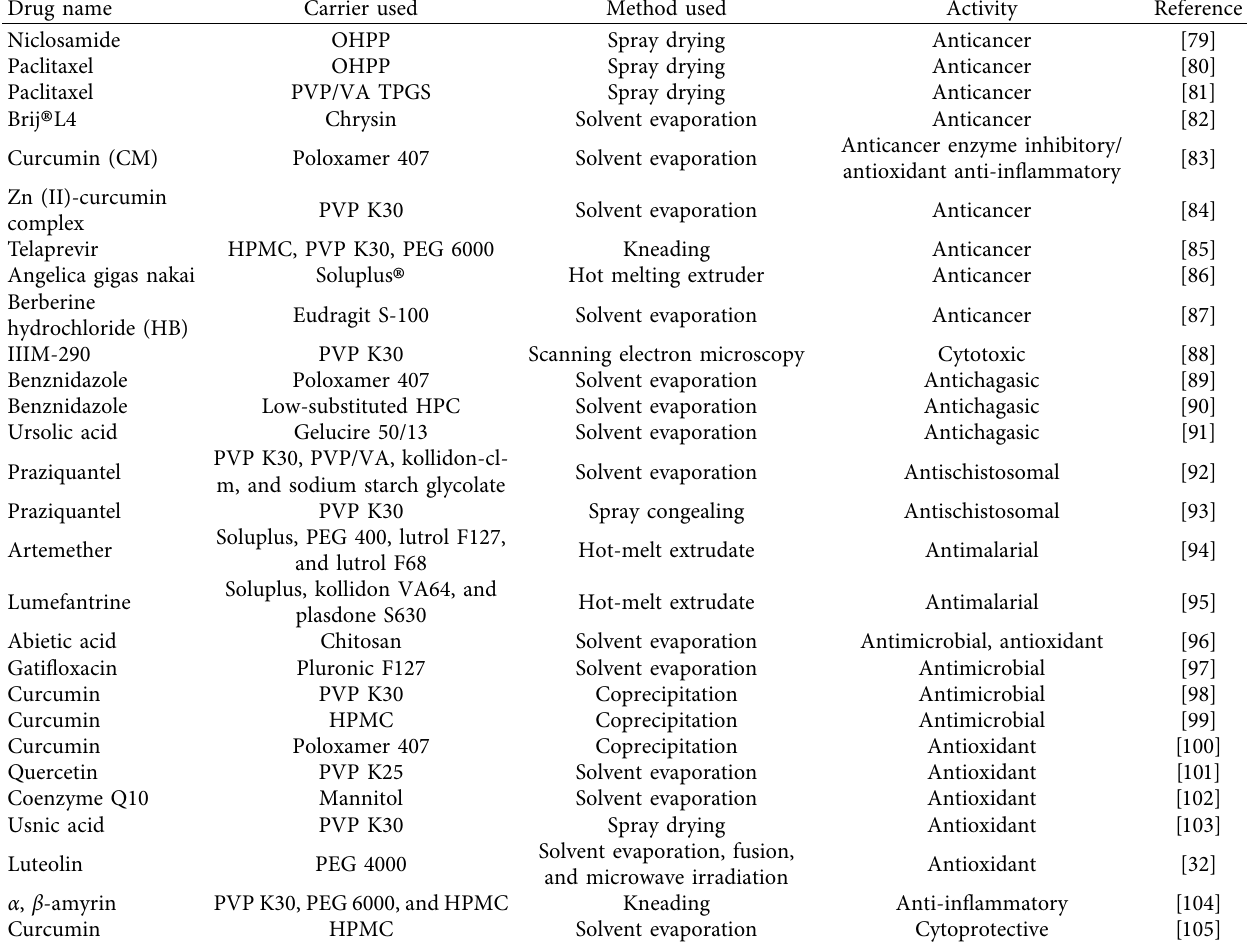
Table 9: In vitro studies on solid dispersion.